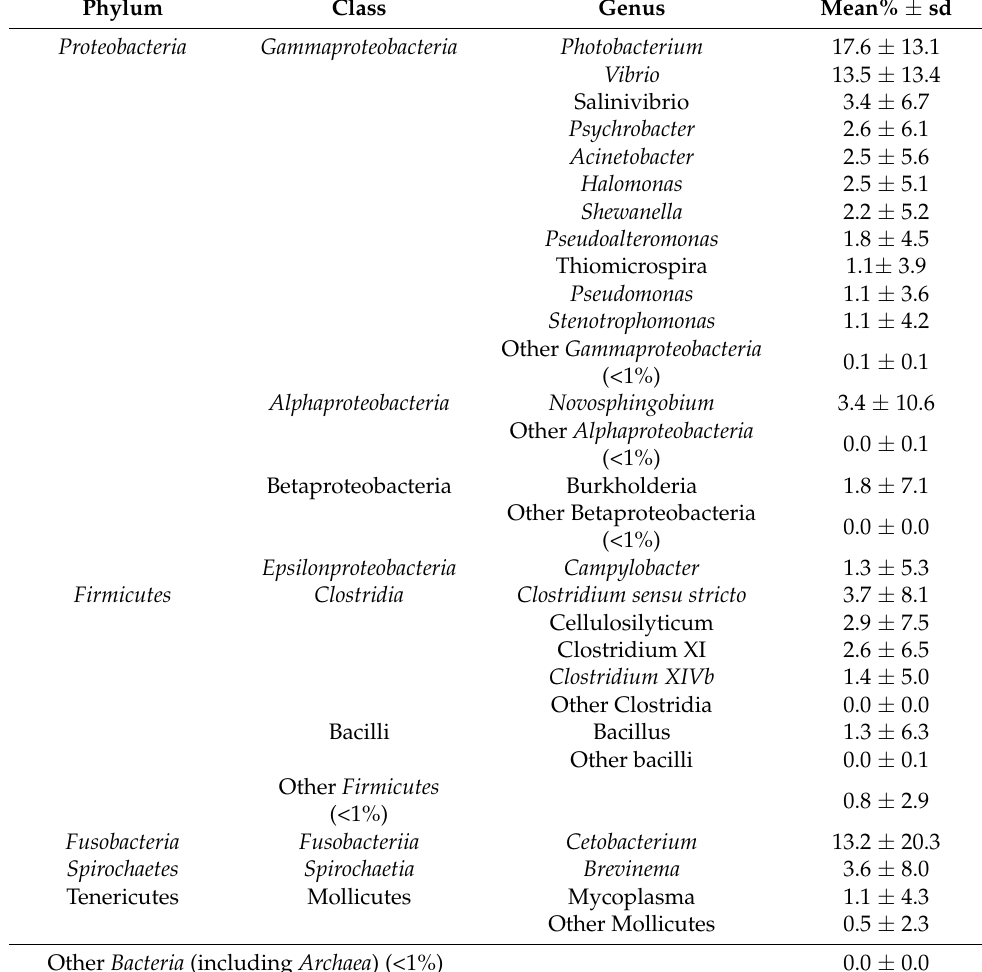
Table 1. Relative abundance of bacterial groups in the gut of Carcharhinus melanopterus